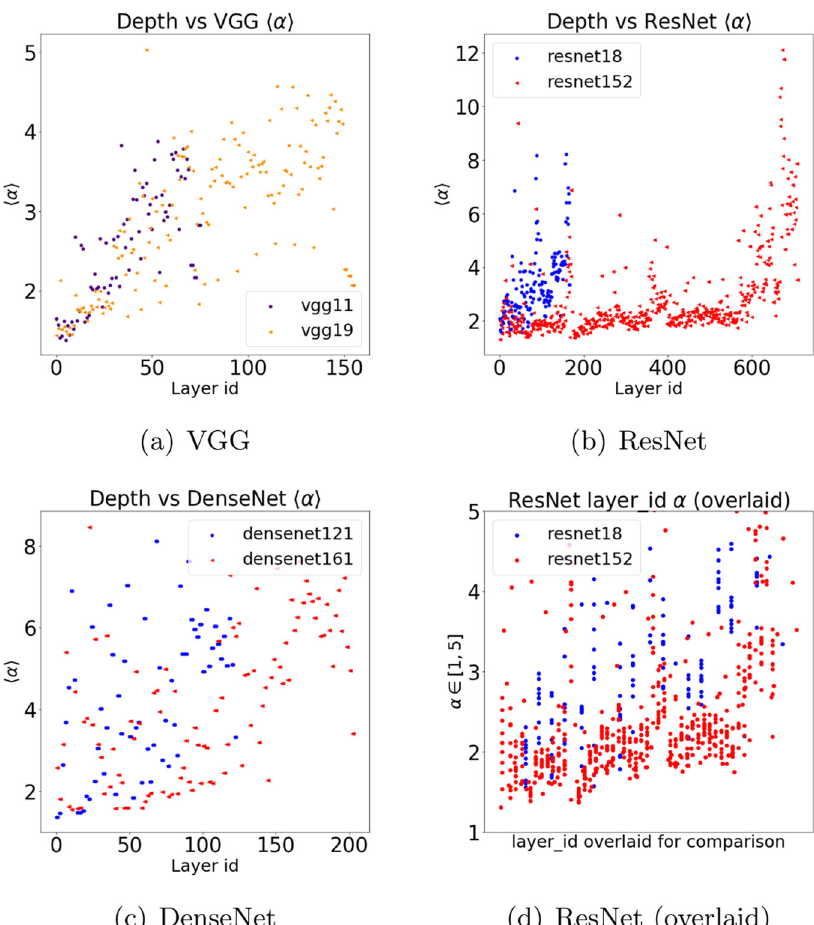
Fig. 4 PL exponent ( α ) versus layer id for VGG, ResNet, and DenseNet. PL exponent ( α ) versus layer id, for the least and the most accurate models in VGG ( a ), ResNet ( b ), and DenseNet ( c ) series. (VGG is without BN; and note that the Y axes on each plot are different.) Sub fi gure ( d ) displays the ResNet models ( b ), zoomed in to α ∈ [1, 5], and with the layer ids overlaid on the X-axis, from smallest to largest, to allow a more detailed analysis of the most strongly correlated layers. Notice that ResNet152 exhibits different and much more stable behavior of α across layers. This contrasts with how both VGG models gradually worsen in deeper layers and how the DenseNet models are much more erratic. In the text, this is interpreted in terms of Correlation